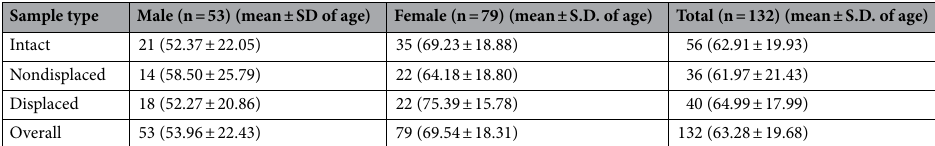
Table 1. Baseline demographic characteristic of femoral fracture from King Chulalongkorn Memorial Hospital.